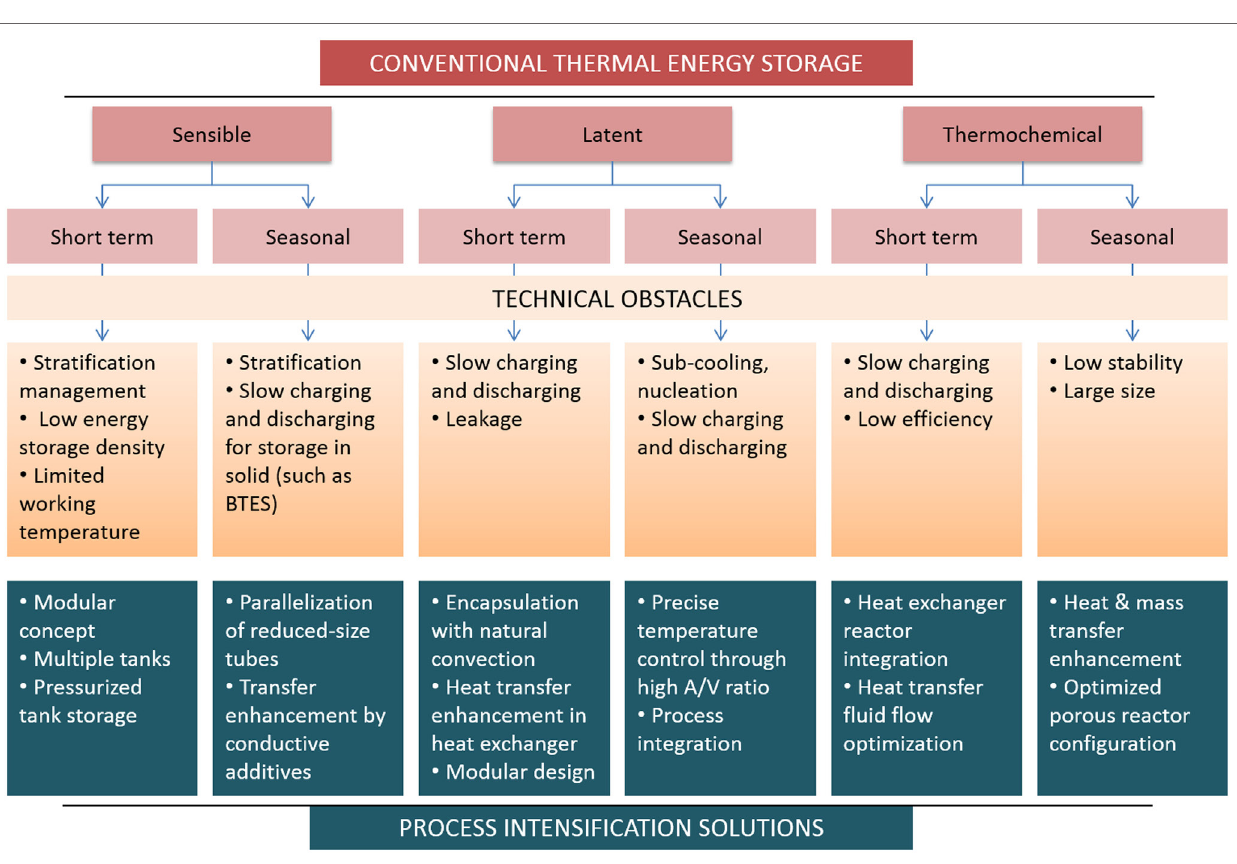
FigURe 3 | Different thermal energy storage systems and their technical obstacles, which might be tackled using process intensification